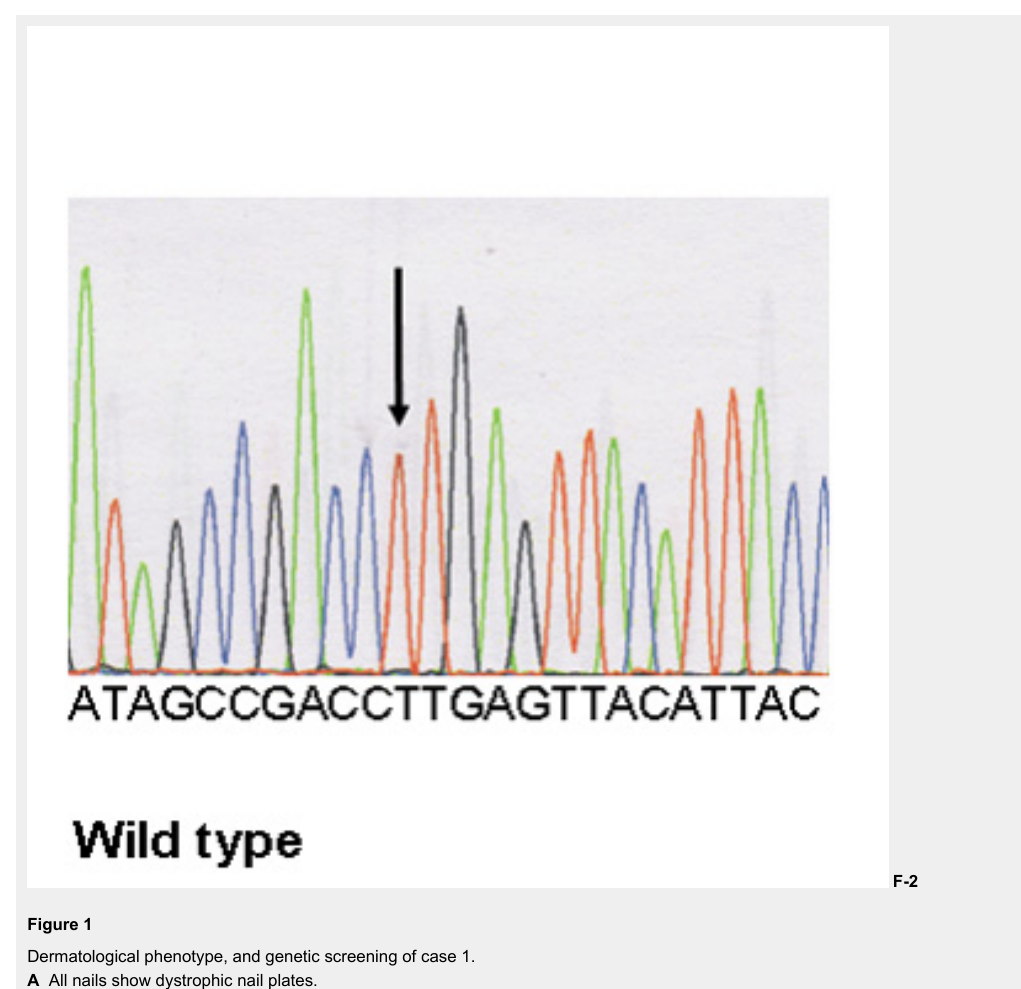
Dermatological phenotype, and genetic screening of case 1. A All nails show dystrophic nail plates. B Striate keratoderma of the palms. C Plantar keratoderma. D Erythemato-squamous skin lesions on the knee. E Curly woolly hair. F Electropherograms of the desmoplakin mutation and of the wild type: a heterozygous variant in DSP , c.1748 T>C, was identified, resulting in the missense mutation p.Leu583Pro at a heterozygous